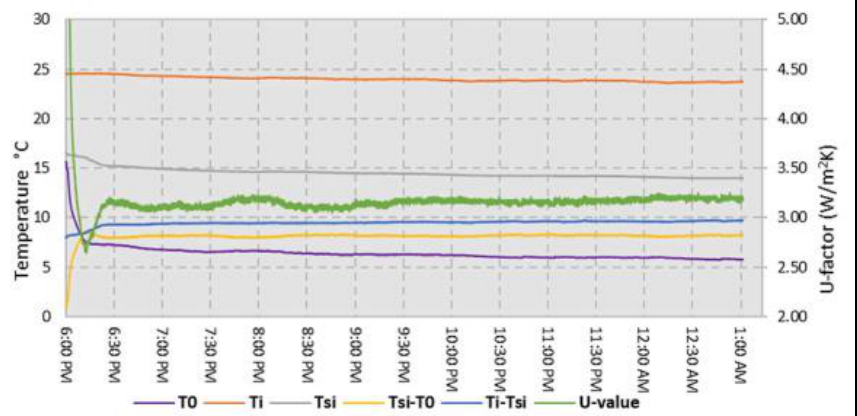
Figure 19. First Measurement [32].